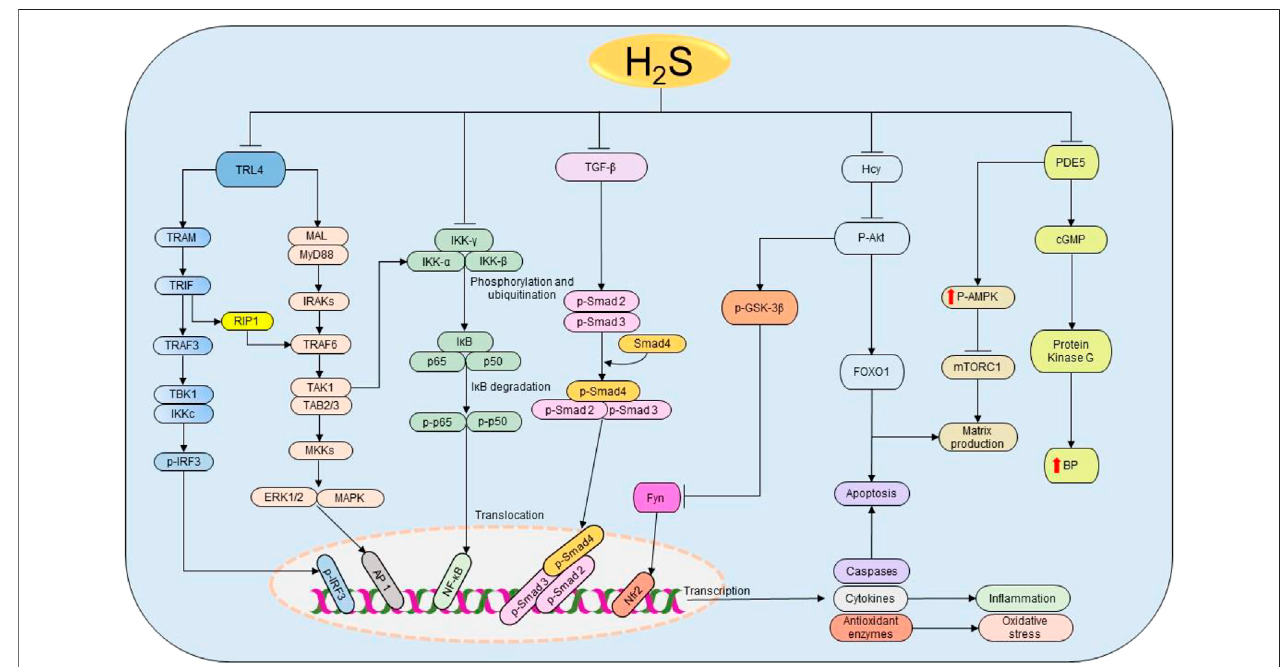
FIGURE 5 | The cellular pathways regulated by H 2 S in renal diseases. Starting from the right-hand side, H 2 S suppresses the expressions of PDE5, thereby enhancing the production of NO and the activation of cGMP and PKG resulting in the subsequent reduction of BP. Simultaneously, PDE5 inhibition facilitates the phosphorylationofAMPK,resultingintheinactivationofmTORC1andthecorrespondingreductionofmatrixproduction.Next,H 2 SreducesHcylevels,therebyinducing the dephosphorylation of Akt and the downstream activation of FOXO 1 signaling pathway, leading to the reduction of apoptosis and matrix production. The deactivation ofAktalso triggers theactivation ofGSK3 β and inhibition ofFynleadingtotheelevation on Nfr2and consequentriseintheantioxidantstatus. Similarly,H 2 S attenuates the activation of TGF- β and its downstream effectors Smad2/3 resulting in the promotion of anti-in fl ammatory activities. Moreover, H 2 S prevents the phosphorylation and ubiquitination of IKK complex, thereby facilitating the inhibition of NF- κ B and subsequently reducing in fl ammation. H 2 S also inhibits TRL4-induced activation of ERK1/2, p38 MAPK, and NLRP3 pathways resulting in the suppression of apoptosis, oxidative stress, and in fl ammation. H 2 S, hydrogen sul fi de; PDE5, phosphodiesterase type 5; cGMP, cyclic guanosine monophosphate; BP, blood pressure; p-AMPK, phosphorylated AMP-activated protein kinase; mTORC1, the mammaliantargetofrapamycincomplex1;FOXO1,forkheadboxproteinO1;Akt,proteinkinaseB;GSK3 β ,glycogensynthasekinase β ;TGF- ꞵ 1,transforminggrowth factor-beta1;Smad2/3/4,mothersagainstdecapentaplegichomolog2/3/4;IKK,I κ Bkinase;I κ B,inhibitorofnuclearfactorkappaB;p50andp65,nuclearfactorkappa B subunits; NF- κ B, nuclear factor kappa B; TRL4, Toll-like receptor 4; MyD88, myeloid differentiation primary response 88; MAL, MyD88 adapter-like proteins; IRAK, interleukin-1 receptor-associated kinases; TRAF, tumor necrosis factor receptor-associated factor; TAK1, TGF- α activating kinase 1; TAB 2/3, TAK 1 binding protein 2/3; MKK, MAPK kinases; TRAM, translocating chain-associating membrane protein; TRIF, TIR-domain-containing adapter-inducing interferon β ; RIP1, receptor- interacting serine/threonine-protein kinase 1; TBK1, TANK-binding kinase 1; IRF3, interferon regulatory factor 3; ERK1/2, extracellular signal-regulated kinase 1/2; MAPK, mitogen-activated protein kinase; AP-1, activator protein 1; NLPR3, NOD-, LRR-, and pyrin domain-containing protein